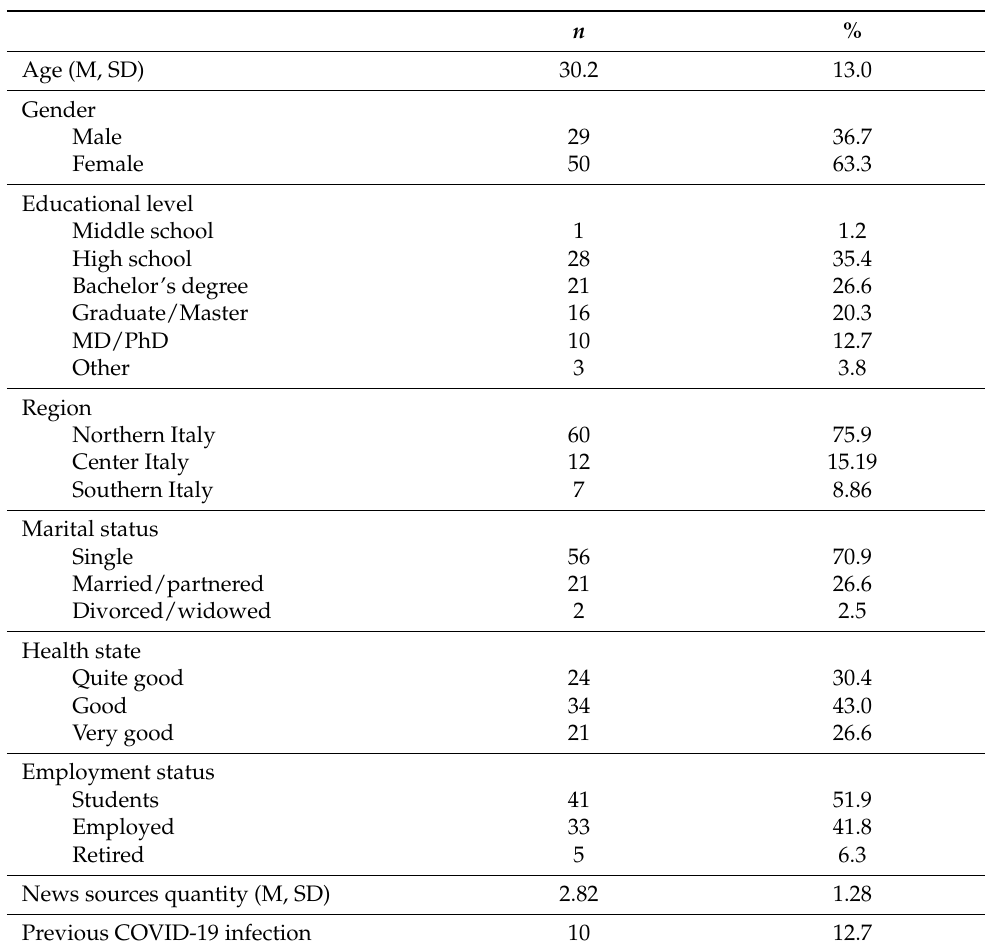
Table 1. Participants’